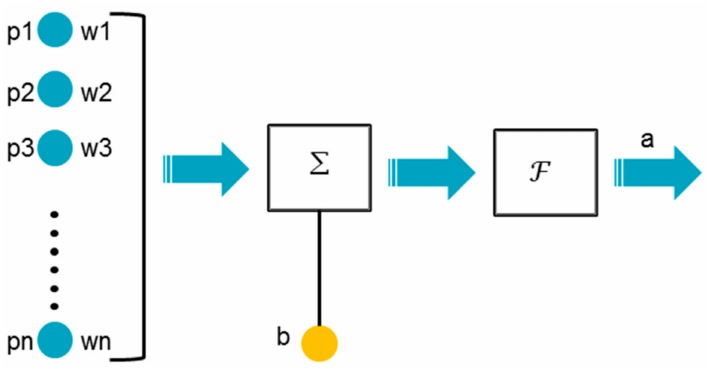
Figure 5. Neuronal